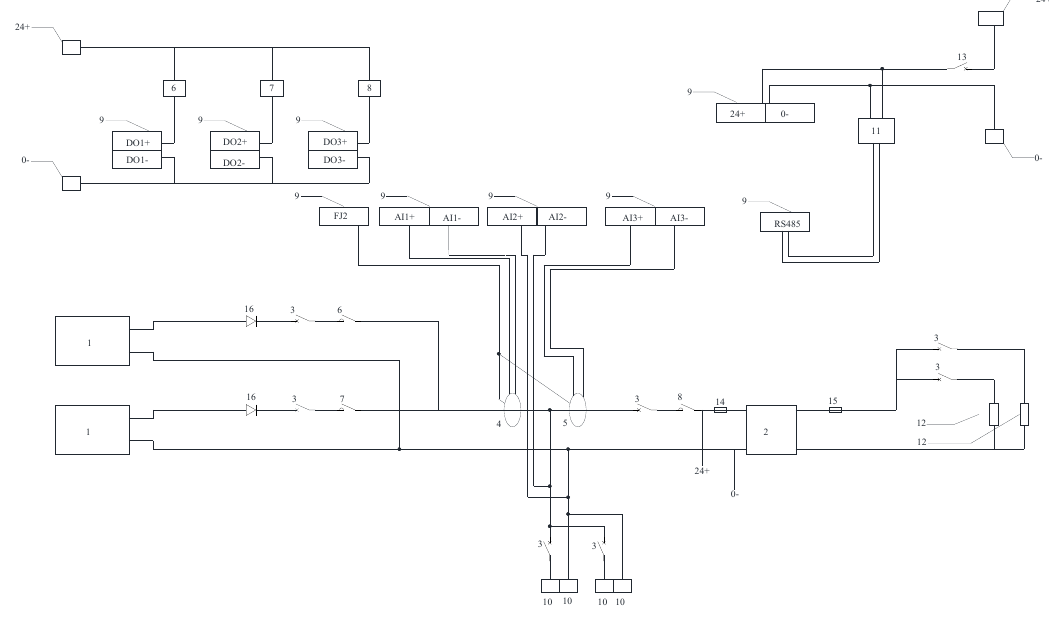
Figure 5. The control circuit of PV power generation. Table 4. The components according to the Figure 5.